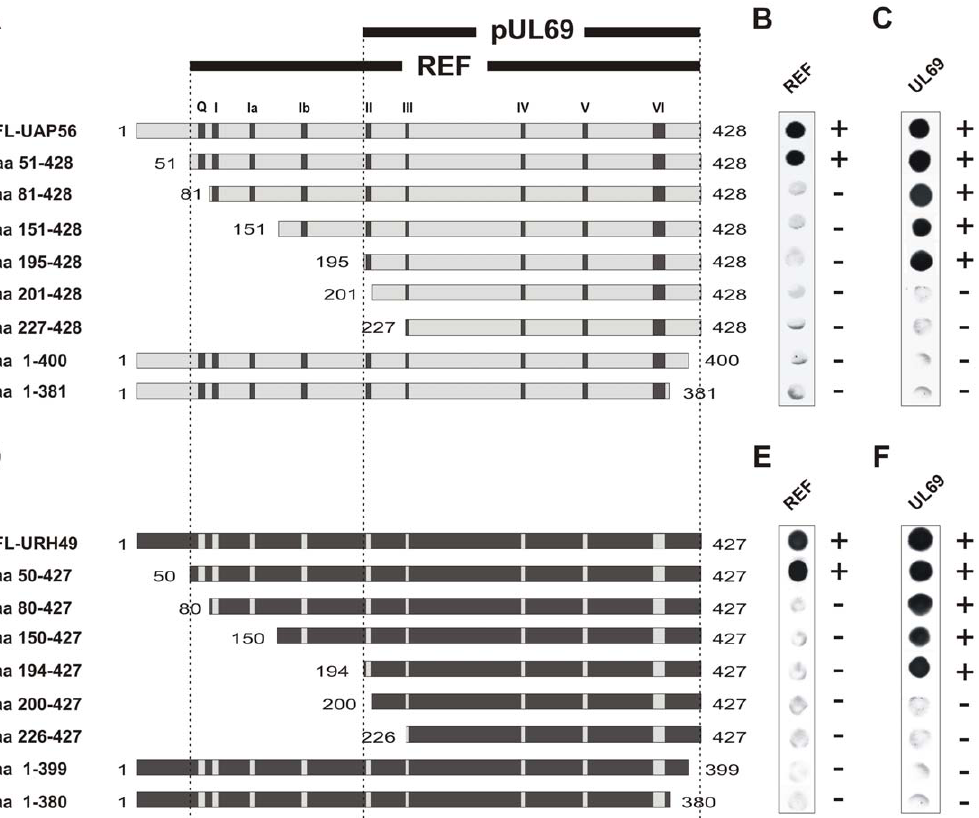
Figure 4. Intracellular localization of UAP56-truncation mutants. (A) Indirect immunofluorescence analyses: HeLa cells were transfected with expression plasmids encoding myc-tagged full-length UAP56 (panels a and b), N- (panels c–m) or C-terminally (panels n–s) truncated UAP56 as indicated. Two days posttransfection cells were fixed and subjected to indirect immunofluorescence analyses using a monoclonal antibody directed against the myc-tag. DAPI, counterstaining of cell nuclei. (B) Schematic representation of the constructs used in (A). (C) Subcellular localization of UAP56 (full-length and truncated) in fusion with the SV40 NLS and b -galactosidase: HeLa cells were transfected with the indicated expression plasmids followed by indirect immunofluorescence analyses using a monoclonal antibody against b -galactosidase (anti- b Gal). (D) Schematic representation of the constructs used in (B). Nuclear localization of the respective construct is indicated by a ‘ + ’, while cytoplasmic localization is indicated by a ‘-‘.